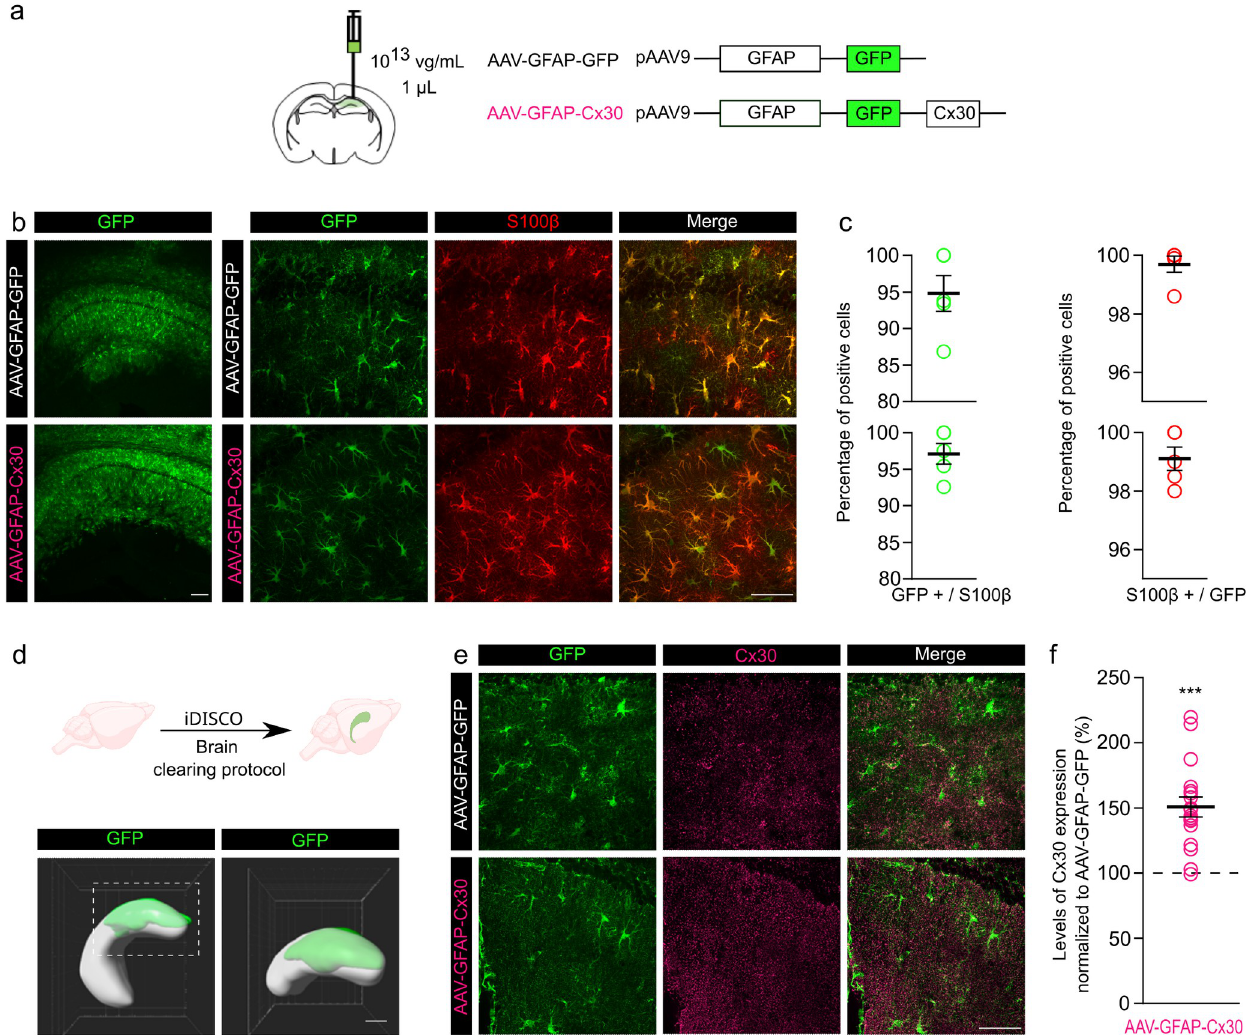
Fig 1. Increased expression of Cx30 in astrocytes from the dorsal hippocampus using in vivo local injection of AAV. (a) Schematic of the experimental procedure and of the viral vector constructs. ( b) Confocal images of the CA1 region after injection of AAV-GFAP-GFP or AAV-GFAP-Cx30 and immunolabeling of GFP (green) at low magnification (left panel), scale bar: 20 μ m or high magnification (right panels), scale bar: 50 μ m. Note that the immunolabeling of S100 β (red) strongly overlaps GFP expression. ( c) Quantification of GFP+/S100 β ( n = 5 ROI) and S100 β +/GFP ( n = 5 ROI) positive cells after injection of AAV-GFAP-GFP (top) or AAV-GFAP-Cx30 transduction (bottom). (d) Reconstructed volume in the hippocampus of the viral transduction (green) after brain clearing protocol iDISCO (left) and at higher magnification of its dorsal part (right). Scale bar: 500 μ m . (e) Confocal images of the CA1 region after injection of AAV-GFAP-GFP or AAV-GFAP-Cx30, and immunolabeling of GFP (green) and Cx30 (purple), scale bar: 50 μ m (left panels). ( f) Quantification of Cx30 expression after AAV-GFAP-Cx30 transduction normalized to AAV-GFAP-GFP ( n = 30 ROI). Individual numerical values are indicated in S1 Data. *** p < 0.001, Welch t